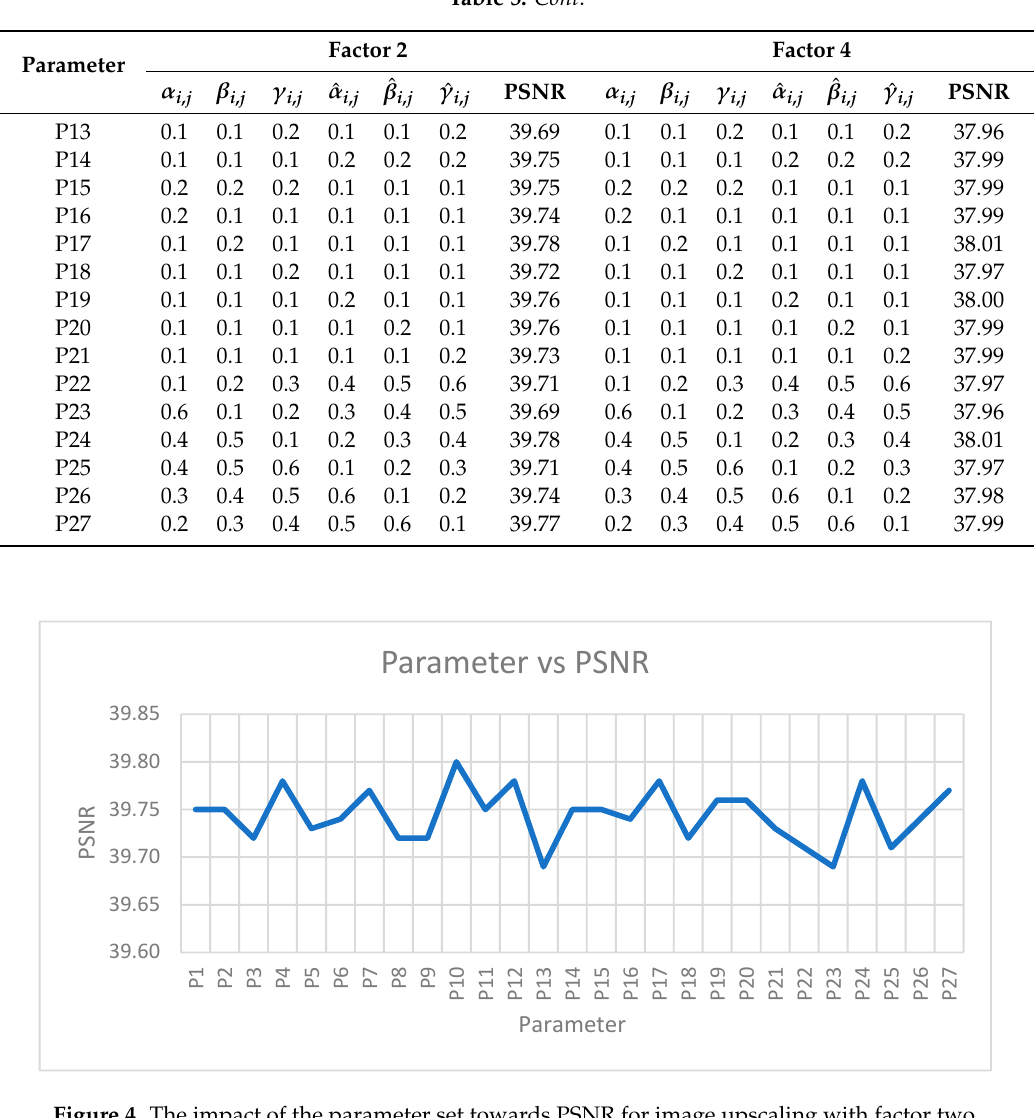
Figure 4. The impact of the parameter set towards PSNR for image upscaling with factor two.